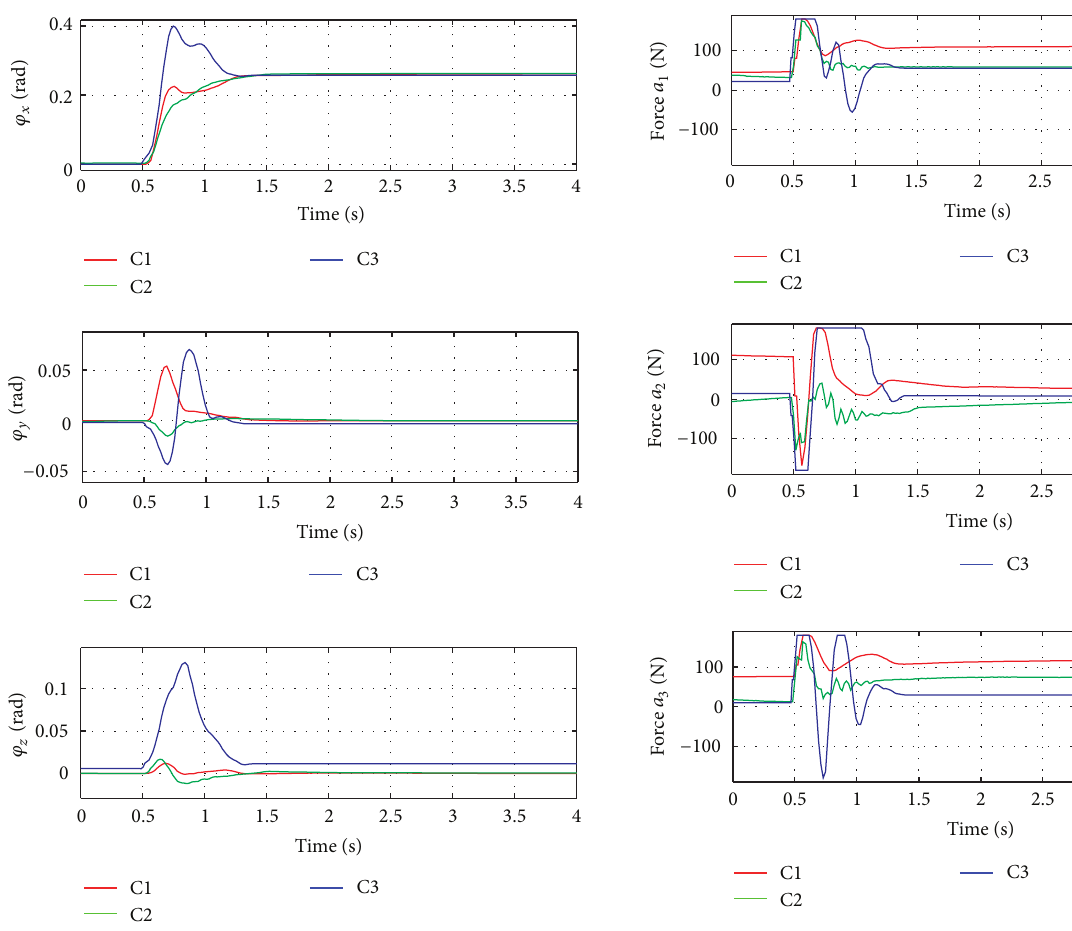
Figure 17: Comparative behavior of the three controllers: actuation